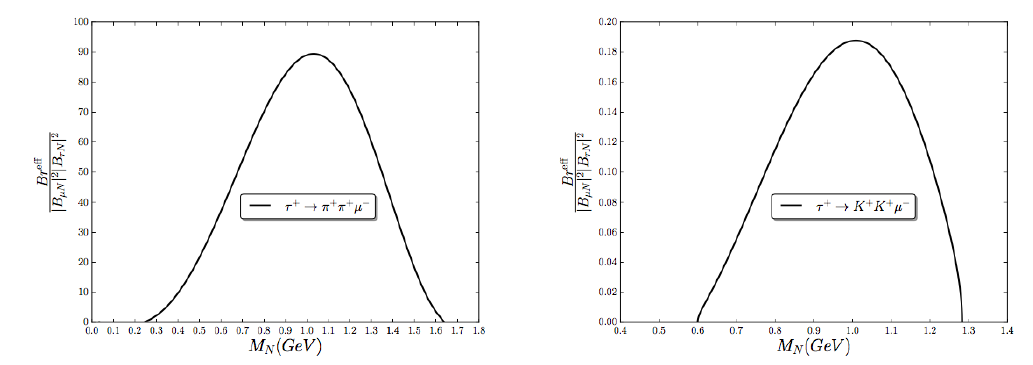
Figure 6 . E(cid:11)ective branching ratios per unit of j B (cid:22)N j 2 j B (cid:28)N j 2 . Here we use the following input p parameters: cos (cid:18) 12 = 1 = 2, overlap factor (cid:14) 12 = 0 : 5, detector length L = 1 mts, neutrino speed (cid:12) = 1 and Lorentz factor (cid:13) N = 2.